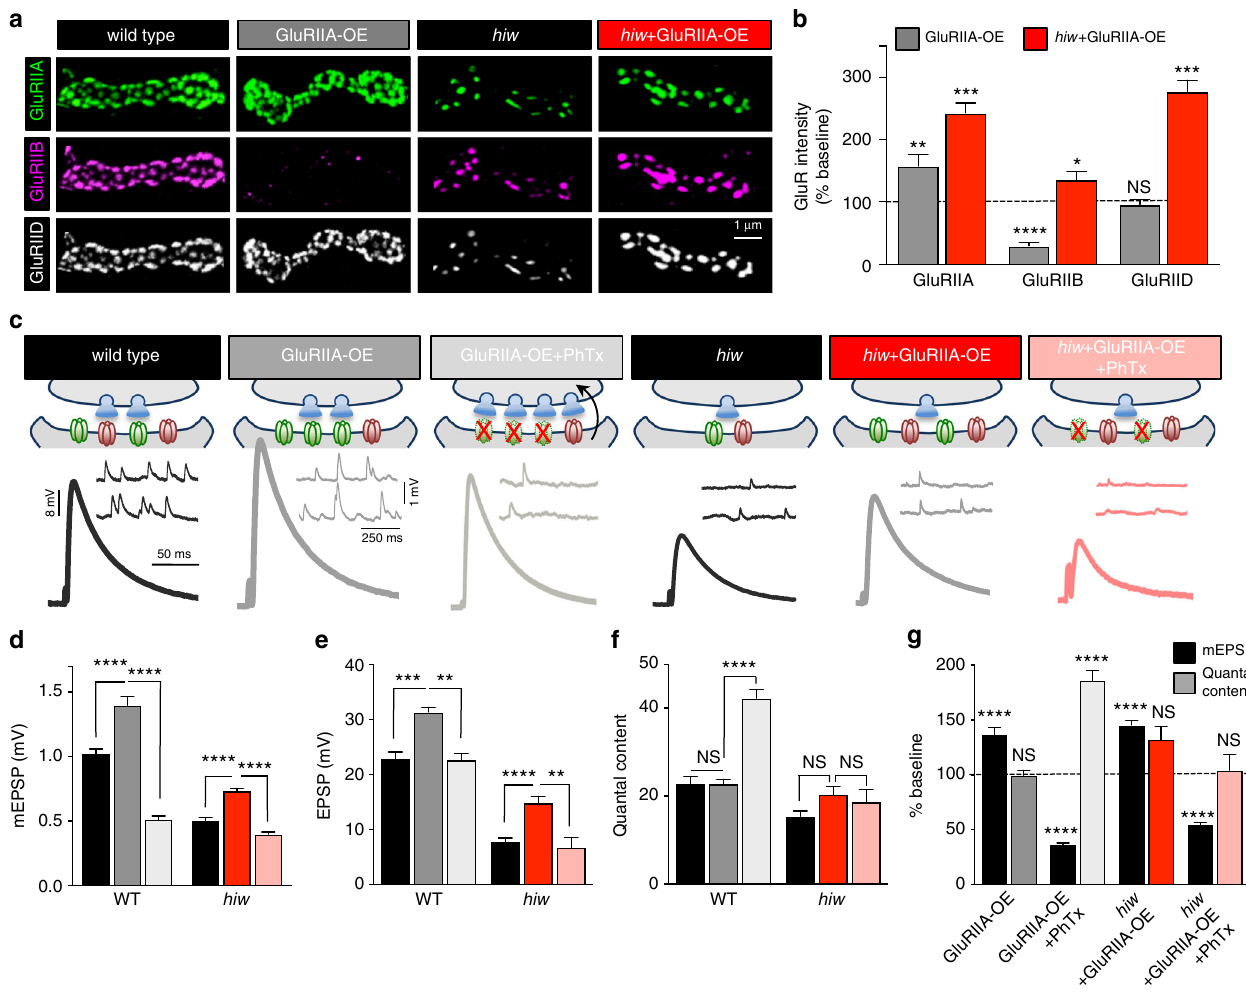
Fig. 7 Increased GluR expression does not restore PHP signaling in hiw -mutant muscle. Representative images ( a ) and quanti fi cation ( b ) of postsynaptic GluR levels at wild-type, postsynaptic overexpression of GluRIIA (GluRIIA-OE; w;MHC-Gal4/UAS-dGluRIIA ), hiw -mutant, and hiw + GluRIIA-OE ( hiw + GluRIIA-OE: hiw Δ N ; MHC-Gal4/UAS-dGluRIIA ) NMJs. GluRIIA-OE in wild-type NMJs results in a reduction in GluRIIB subunits, leaving GluRIID levels unchanged, while all glutamate receptor subunits are increased in hiw + GluRIIA-OE compared to hiw mutants alone. c Schematic illustrating postsynaptic overexpression of GluRIIA in wild type and hiw mutants at baseline and following PhTx application. Application of PhTx to GluRIIA-OE NMJs leads to a homeostatic increase in presynaptic release, while this increase is not observed in hiw + GluRIIA-OE NMJs. Representative mEPSP and EPSP traces of the indicated genotypes are shown below. Quanti fi cation of mEPSP amplitude ( d ), EPSP amplitude ( e ), and quantal content ( f ) in the indicated genotypes. g Quanti fi cation of mEPSP and quantal content values normalized to baseline (without GluRIIA-OE) in the indicated genotypes. For GluRIIA-OE + PhTx and hiw + GluRIIA-OE + PhTx, values are normalized to GluRIIA-OE and hiw + GluRIIA-OE, respectively. Error bars indicate ± SEM. For statistical signi fi cance, an unpaired t -test was performed between respective genotypes with and without GluRIIA-OE. * p ≤ 0.05; ** p 0.01; *** p 0.001; **** p 0.0001; NS not signi fi cant, p >